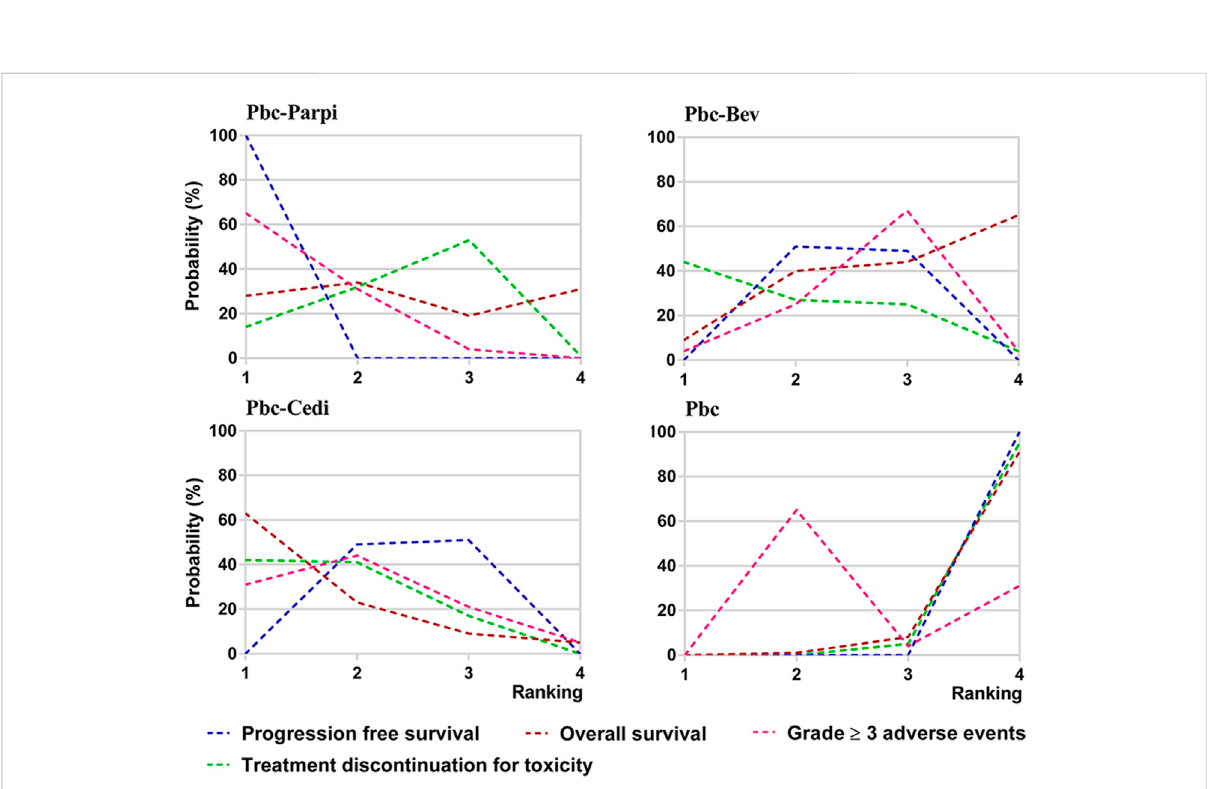
FIGURE 8 Bayesian ranking curves of maintain therapies on ef fi cacy. The probability of each comparable treatment being ranked from fi rst to last on progression-free survival, overall survival, grade ≥ 3 adverse events, and treatment discontinuation for